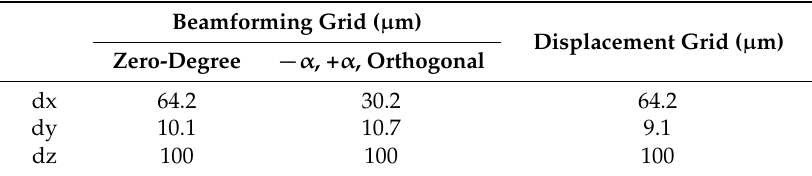
Figure 4. The first column depicts the grid configurations for both probes in which the overlay of all steered and non-steered grids results in a displacement grid consisting of coinciding sample-locations. Columns 2, 3, and 4 show the B-mode representations of the actual transmissions performed subsequently overlaid with a displacement grid and a single line indicating the direction of the reconstructed ultrasound beam in receive. The schematic drawing of the aperture indicates the +45 ◦ and − 45 ◦ angles of insonification relative to the phantom for probe A and B, respectively. The last column shows the RF data registration in which the axial direction of the probes serves as a native lateral ultrasound transmission of the opposite probe. Table 1. Resolution of interlocked steered and non-steered